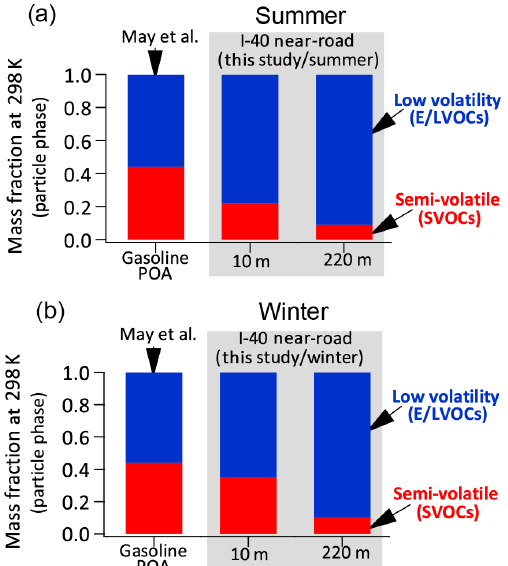
Figure 7. Comparison of volatility classification of near-road parti- cles measured at 10 and 220m (this study) for (a) summer and (b) winter at a reference temperature of 25 ◦ C. Distributions of particle- phase material are shown using two broad volatility categories. Also shown in both panels is the POA distribution from gasoline vehicle exhaust by May et al. (2013a) under typical near-road aerosol load- ing ( C OA ∼ 5µgm − 3